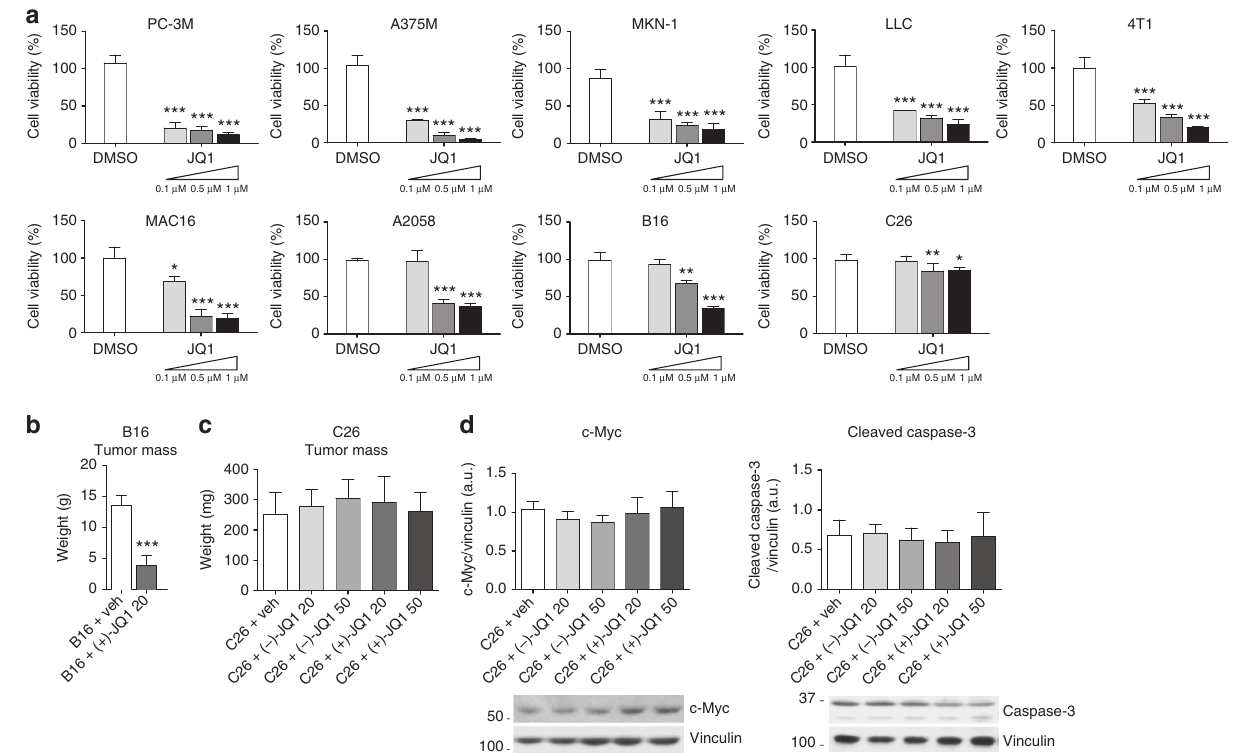
Fig. 1 Response to JQ1 in cancer cell lines used to study cancer cachexia. a Viability rates of JQ1-treated cells, calculated by measuring the viable cell number after 72 h in culture. Results are normalized to the proliferation of vehicle/DMSO-treated cells, set to 100% ( n = 3). Statistical analysis was performed by using one-way ANOVA followed by Tukey ’ s post hoc test. Data represent means ± SD. * p < 0.05; ** p < 0.01; *** p < 0.001 vs. DMSO. b Ten days after B16-tumor cells inoculation, mice were treated either with vehicle or (+)-JQ1 (20 mg/kg/day) for 10 days. Tumor weight after necropsy is shown. Animals per group: n = 7. Data represent means ± SD. Statistical analysis was performed by using Student ’ s unpaired t -test. *** p < 0.001 indicates statistical signi fi cance vs. B16 + veh. c Tumor weight at the day of sacri fi ce (day 12) in C26-tumor-bearing mice (animals per group: n = 10). Data represent means ± SD. Statistical analysis was performed by using one-way ANOVA followed by Tukey ’ s post hoc test. d c-Myc and cleaved-Caspase-3 levels were quanti fi ed by immunoblots using tumor whole extracts (animals per group: n = (Fig. 2b). Importantly, even at the lowest dose (20 mg/kg/day), (+)-JQ1 treatment was associated with a signi fi cantly ( p = 0.0004,